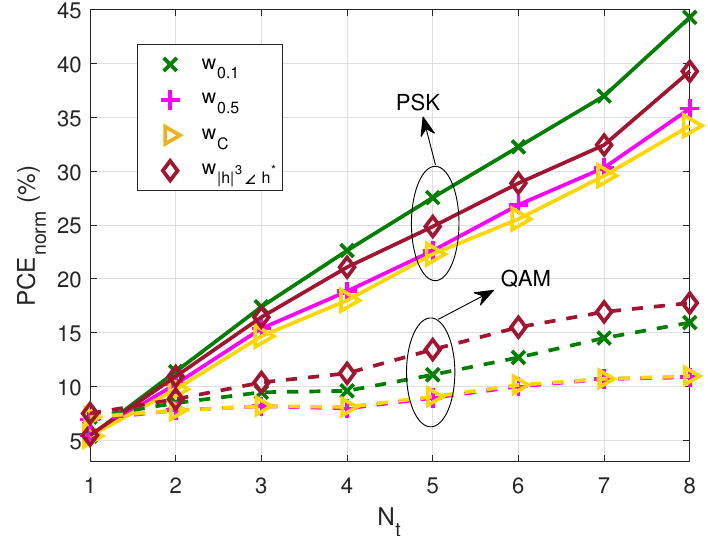
Figure 13. Normalized PCE using multisine PSK modulation and QAM modulation as a function of N t for multisine based SWIPT system with ρ = 0.5 and B = 1 MHz.